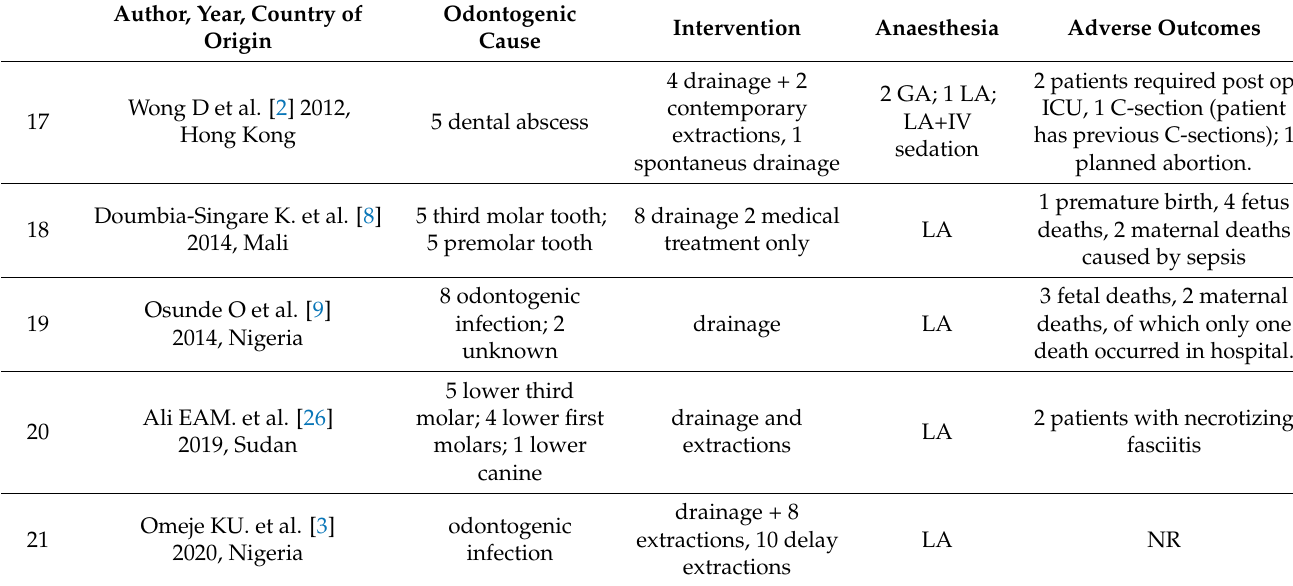
Table 4. Summary of odontogenic cause, surgical treatment, and adverse